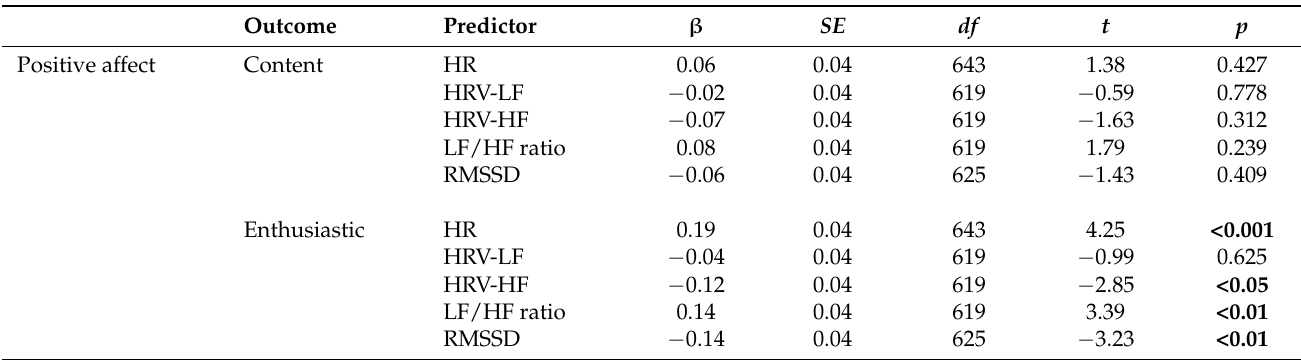
Table 6. Within-individual associations of HR and HRV parameters with an epoch length of 5 min before filling out ESM questionnaires with single affect items stratified for being in an upright